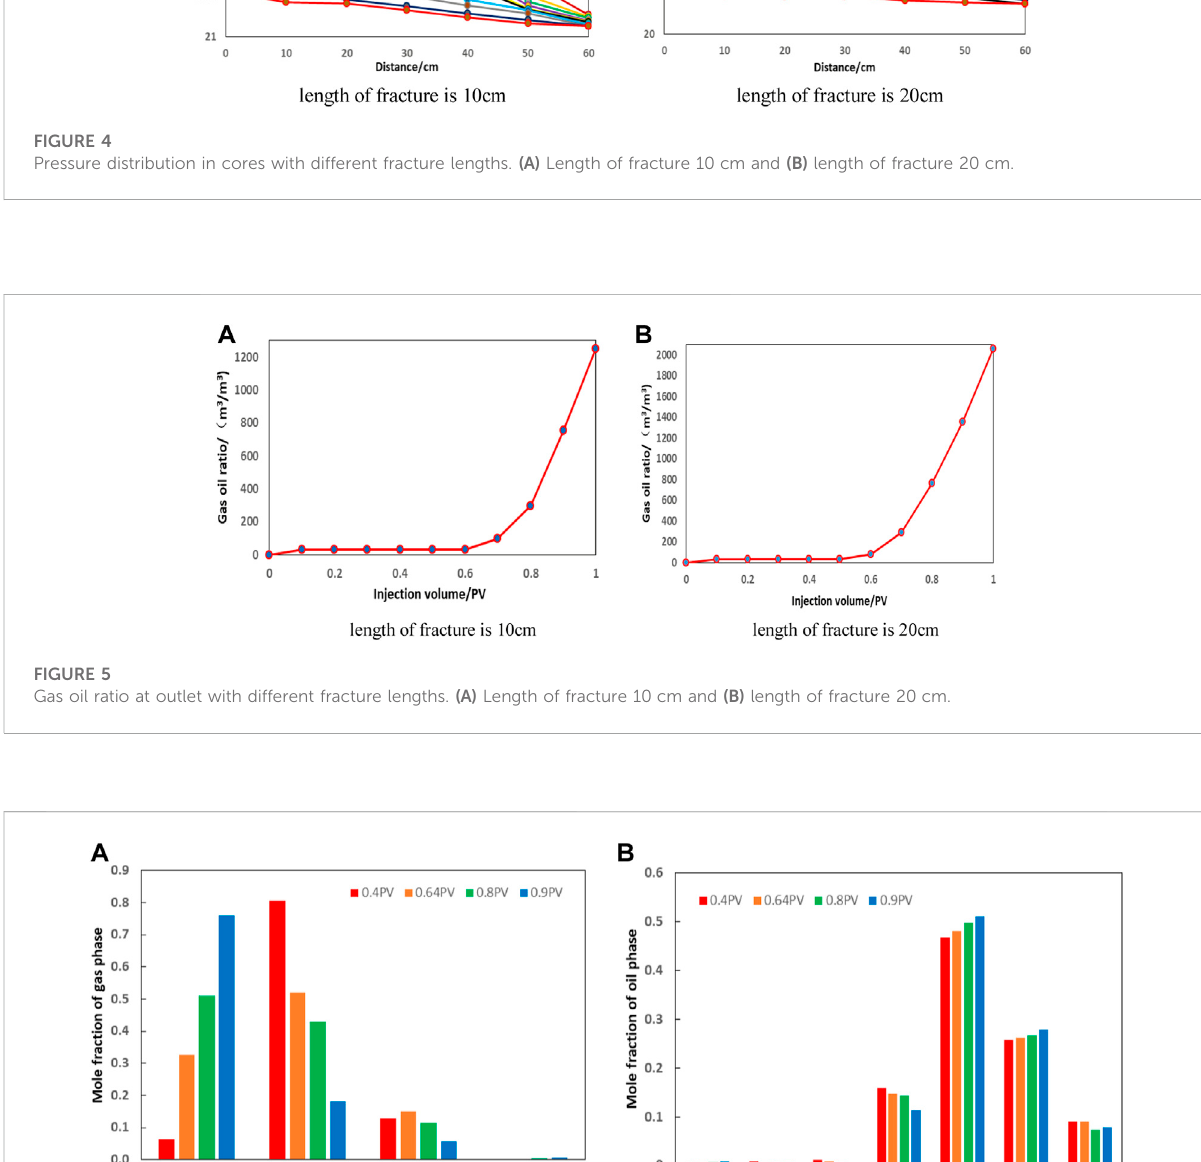
Frontiers in Earth